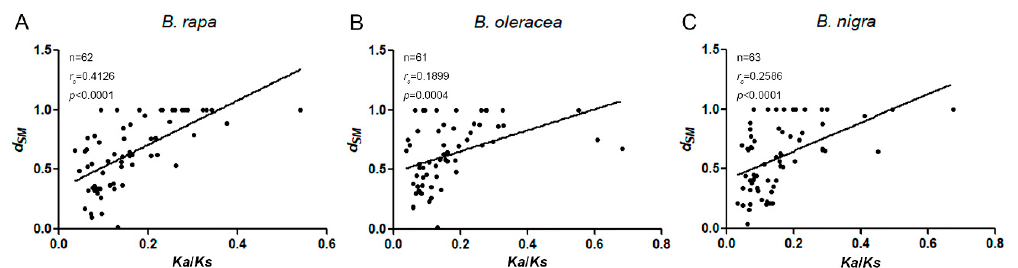
Figure 9. Correlation between d SM and Ka / Ks of orthologous expansin gene pairs between A. thaliana and B. rapa ( A ), A. thaliana and B. oleracea ( B ), and A. thaliana and B. nigra ( C ). We found significant positive correlations between Ka / Ks and shared motif divergence in sequences 0–500 bp upstream of translation start of orthologues (Pearson correlation). Linear fits of these data are also plotted (A: y = 0.336 + 1.856 x ; B: y = 0.479 + 0.879 x ; C: y = 0.410 + 1.199 x ).